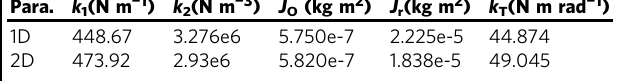
Table 2 Equivalent parameters of the attached